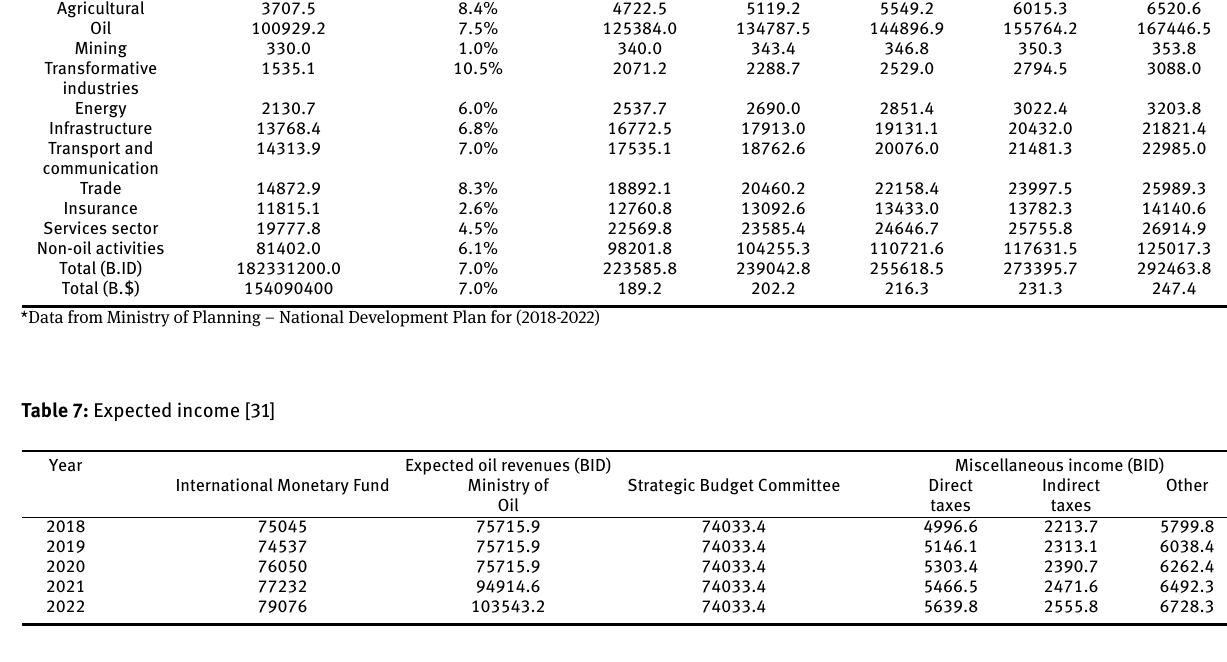
Table 6: Target Growth Rates of the Gross Domestic Product (GDP) for (2018-2022)*